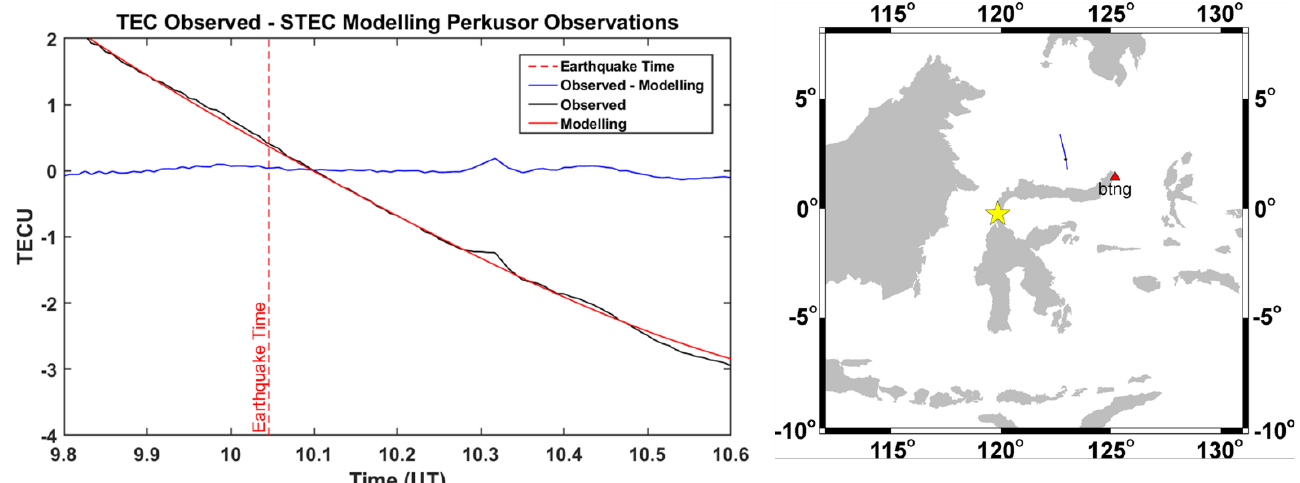
Figure A1. The slant of TEC changes before and after 2018 Palu earthquake measured from BTNG station using GPS PRN 21; the result is similar to that of Mikesel et al. 2019 ( left ). The variation of TEC slant (black) modelled with polynomial degree up to 6 (red). The strong positive peak shows the earthquake CID (indicated by the blue circle). The red vertical dashed lines in the time series indicate the time of the 2018 Palu Sumatra earthquake mainshock (10:02:45 UT). Furthermore, on the trajectories of GPS PRN 21 ( right ), small red stars indicate the SIP at the mainshock event. The yellow star indicates the epicenter, while the red triangle indicates GPS stations.